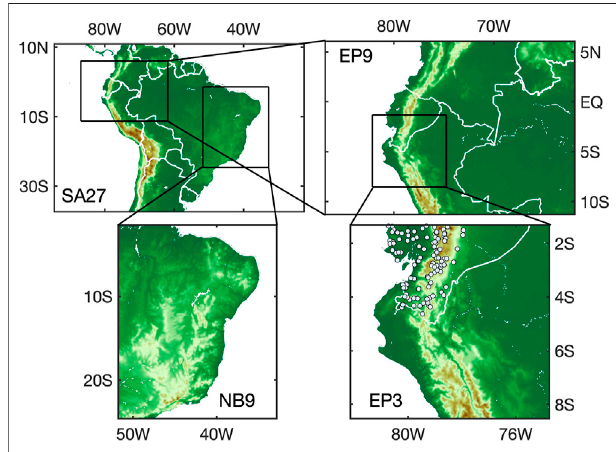
FIGURE 1 | Regional dynamical downscaling over the Ecuadorian- Peruvian and Brazilian domain. In a nested approach, the input data of the ERA-Interimreanalysesisdownscaled to27 km(SA27),9 km(EP9) and 3 km (EP3) over Ecuador-Peru and to 9 km (NB9) over Northeast Brazil. The dots in EP3 represent 106 selected precipitation gauges of the Ecuadorian Weather Service INAMHI that have less than 5% of missing values during Jul 2006 – Jun